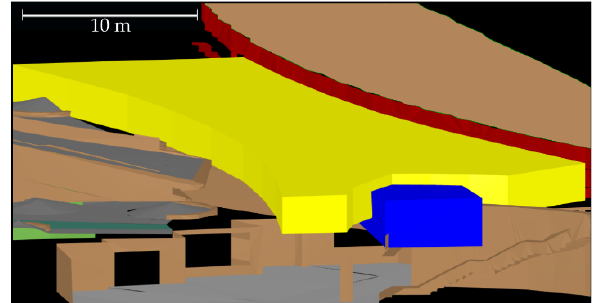
Figure 3: Part of the virtual 3D model of the Planetarium Rio Tinto Alcan (Montreal city) visualized from a point of view that maximizes 3D overlapped geometric objects’ view area inside the viewport. Buildings and urban facilities are displayed in brown, ground in grey, green spaces in green and the easement in yellow. A 3D object (in blue) is added as an example of RRR conflict with the